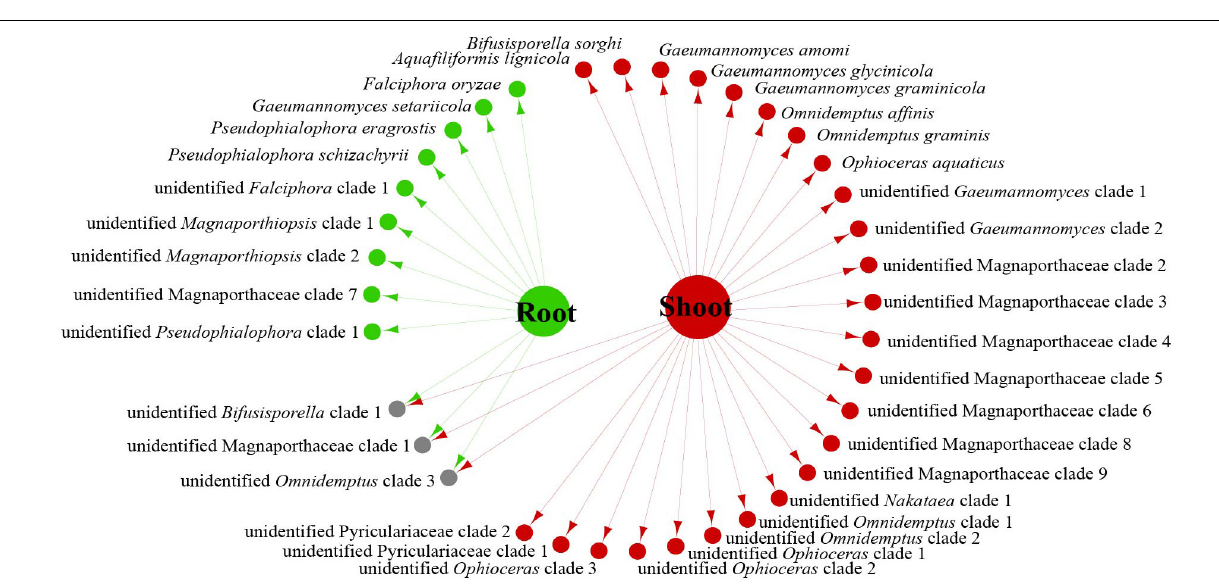
FIGURE 3 | Network of endophytic fungal Magnaporthales species diversity from shoots and roots of gramineous plants in Yunnan, Zhejiang, and Inner Mongolia.